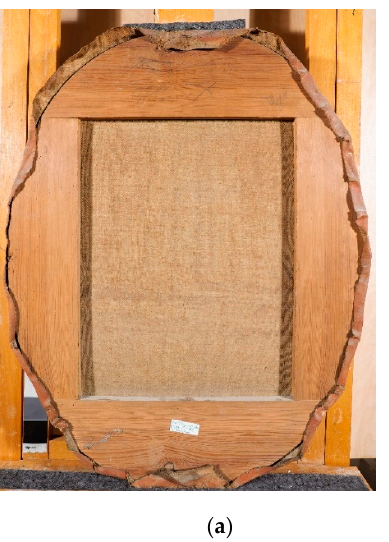
( c ) Figure 4. The verso of F. Hauch (KMS349): ( a ) displaying the likely original French strainer with inscription “ F.v. Hauch Malet i Aaret 1776 i Paris af Professor Juel ” (F.v. Hauch painted in 1776 in Paris by Professor Juel). Juel did not become Professor until the mid-1780s, thus the inscription is added to the strainer postproduction; ( b ) a detail, displaying the half-lap joint; ( c ) detail of the central lower member displaying rippling from a hand plane and a pencil-line indication of the major axis. 3. Tool Marks on the Strainers The surface of the original strainer bars of the Svenstrup paintings bear marks corre- sponding to tools used in the eighteenth century. After sawing, diverse types of planes would have been used to remove sawing marks and other irregularities (Williams 2008).